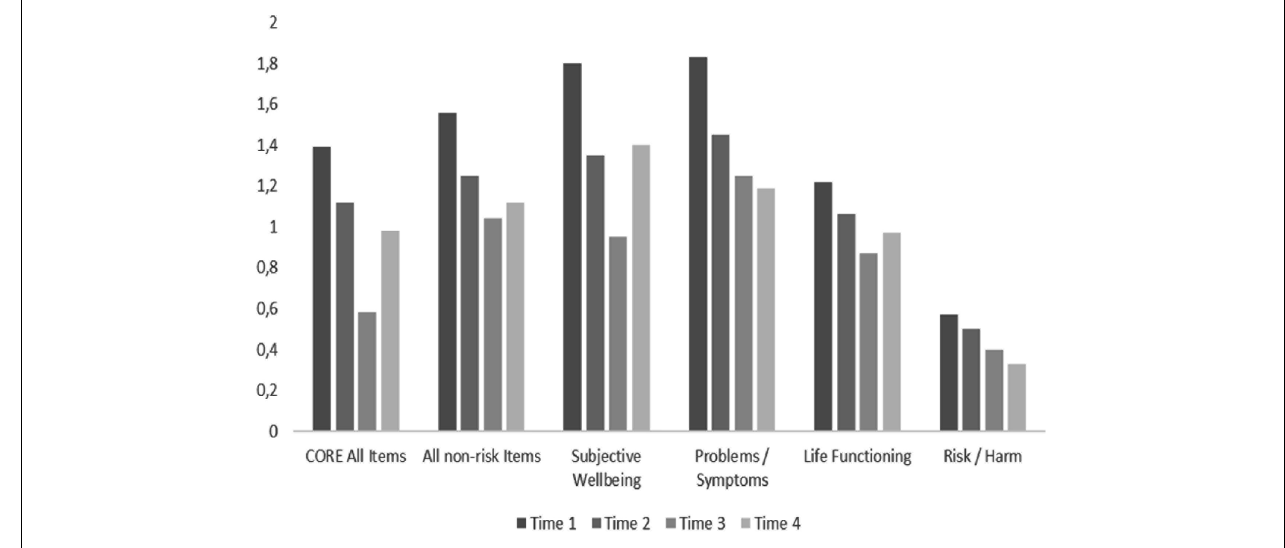
FIGURE 1 | Group CORE means of scores over time.